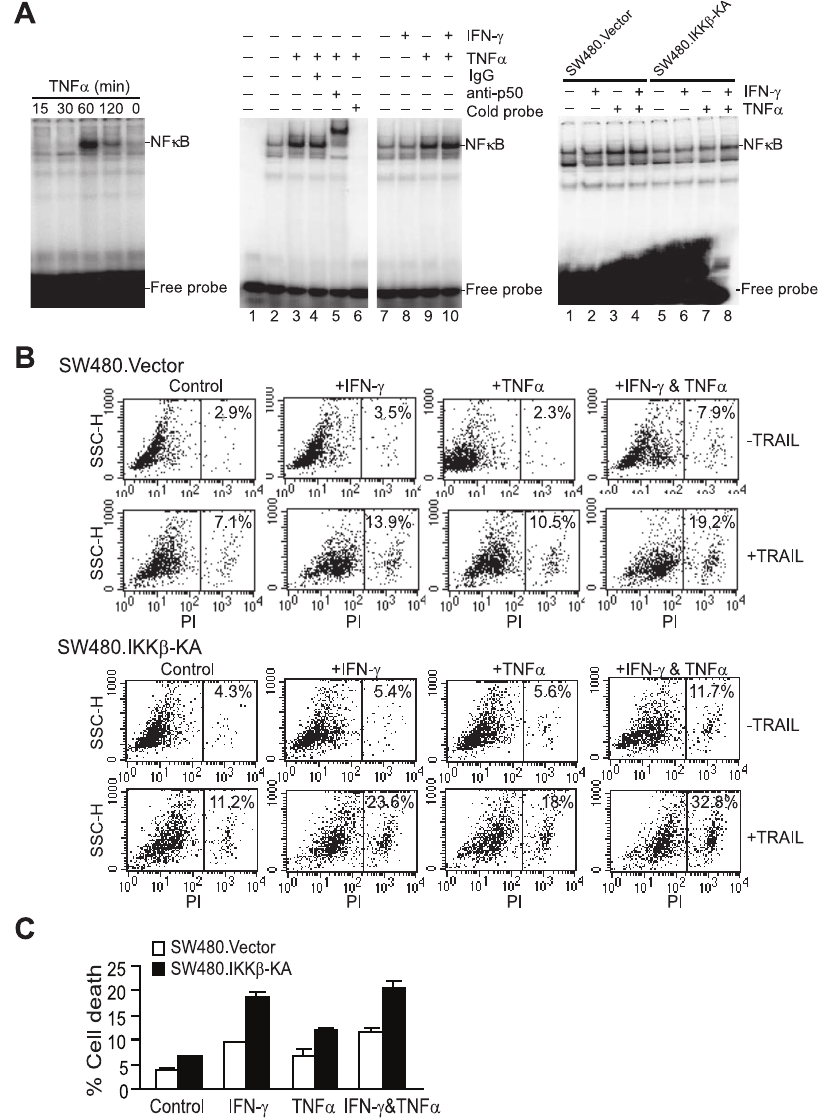
Figure 4. TNF a -mediated NF- k B activation on TRAIL-induced apoptosis. A . Analysis of IKK b -KA-mediated inhibition of NF- k B activation. Left panel: TNF a -induced NF- k B activation kinetics. SW480 cells were treated with TNF a for the indicated time. Nuclear extracts were prepared and used in the EMSA using a double-stranded oligo nucleotide probe containing NF- k B consensus sequence. Middle panel: specificity of NF- k B EMSA. SW480 cells were treated with IFN- c , TNF a or both IFN- c and TNF a for 60 min and analyzed for NF- k B activation by EMSA. IgG (lane 4), anti-p50 subunit of NF- k B antibody (lane 5), and excess molar ratio of cold probe (lane 6) were used for the specificity assay. Right panel: inhibition of NF- k B activation by IKK b -KA mutant. SW480.Vector and SW480.IKK b -KA cells were treated with IFN- c , TNF a or both IFN- c and TNF a for 60 min and used in the EMSA assay as shown above. B . Sensitivity of SW480.Vector and SW480.IKK b -KA cells to TRAIL-induced apoptosis. Tumor cells were treated with IFN- c , TNF a , or both IFN- c and TNF a overnight, followed by incubation with recombinant TRAIL for approximately 24 h. Cells were then stained with PI and analyzed for cell death. C . Quantification of TRAIL-induced cell death. Cell death as shown in B was